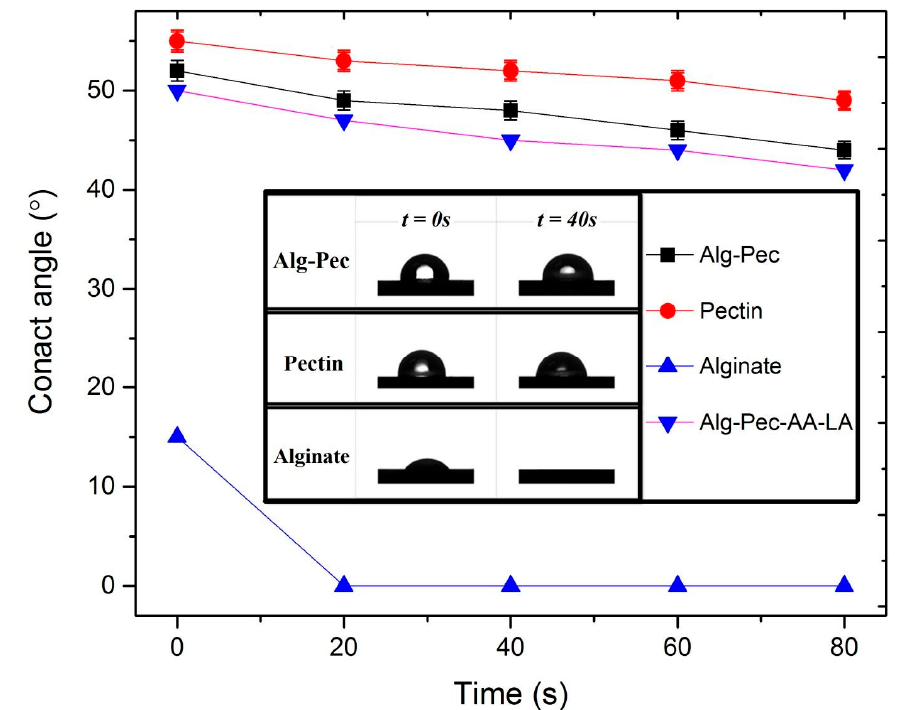
Figure 6. Water contact angle evaluation of alginate–pectin based films over time.